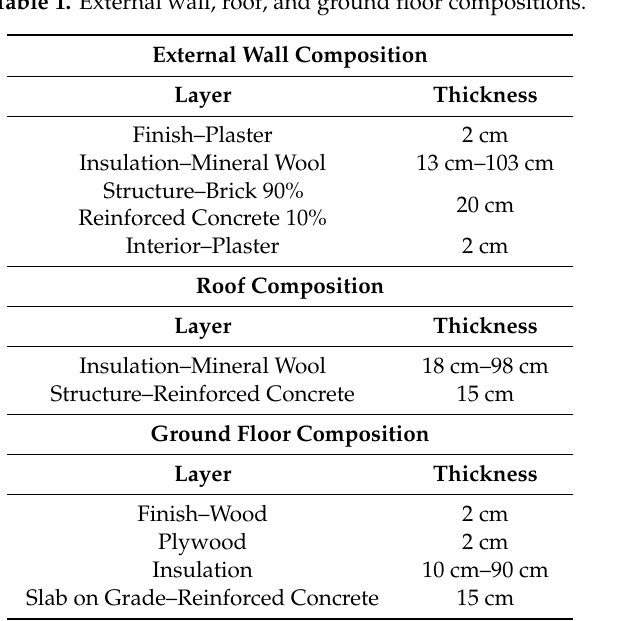
Table 1. External wall, roof, and ground floor